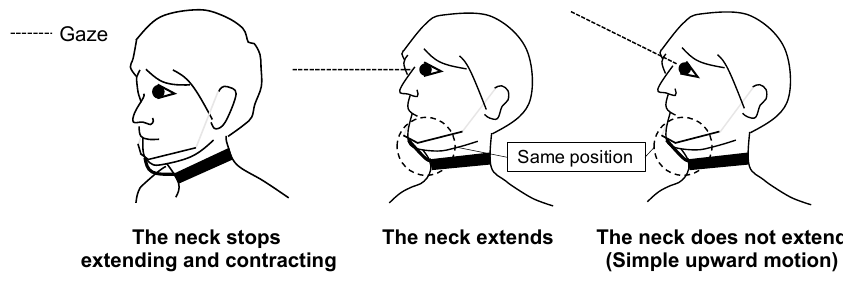
Figure 20. Diagram showing how to distinguish between daily motions and gesture